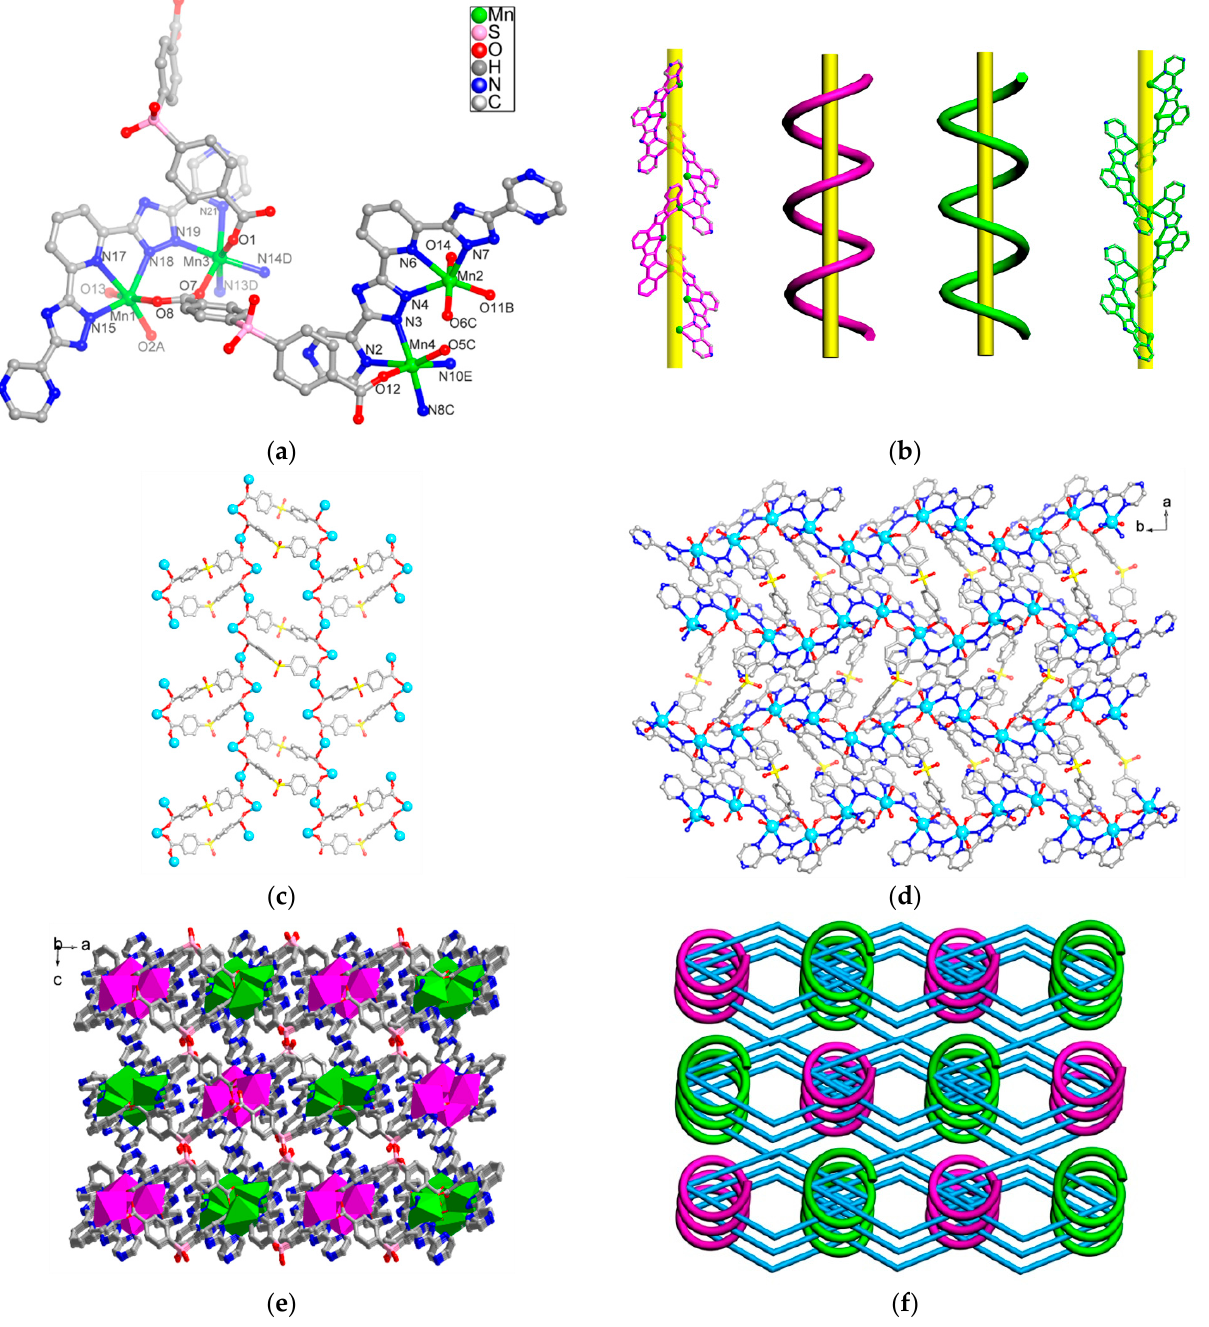
Figure 1. ( a ) Local coordination environment of Mn(II) ions in 1 . ( b ) Left ‐ and right ‐ stranded helices constructed from ptptp 2 − ligands. ( c ) 2D layer constructed by sdba 2 − ligands. ( d ) 2D layer constructed by sdba 2 − and ptptp 2 − ligands. ( e ) Perspective view of 3D supramolecular framework. ( f ) The simplified sketch of the entire 3D